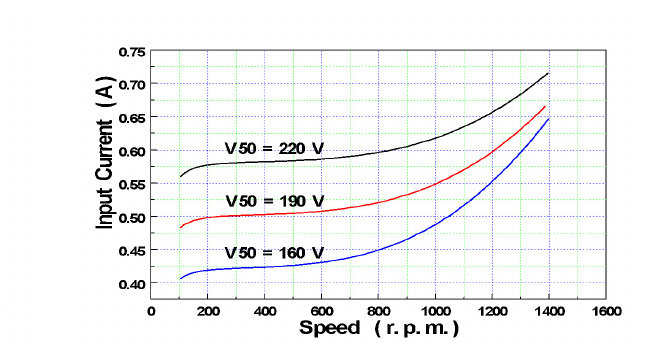
Fig. 3. Variation of the motor’s applied voltage as a function of rotor speed (Computed).